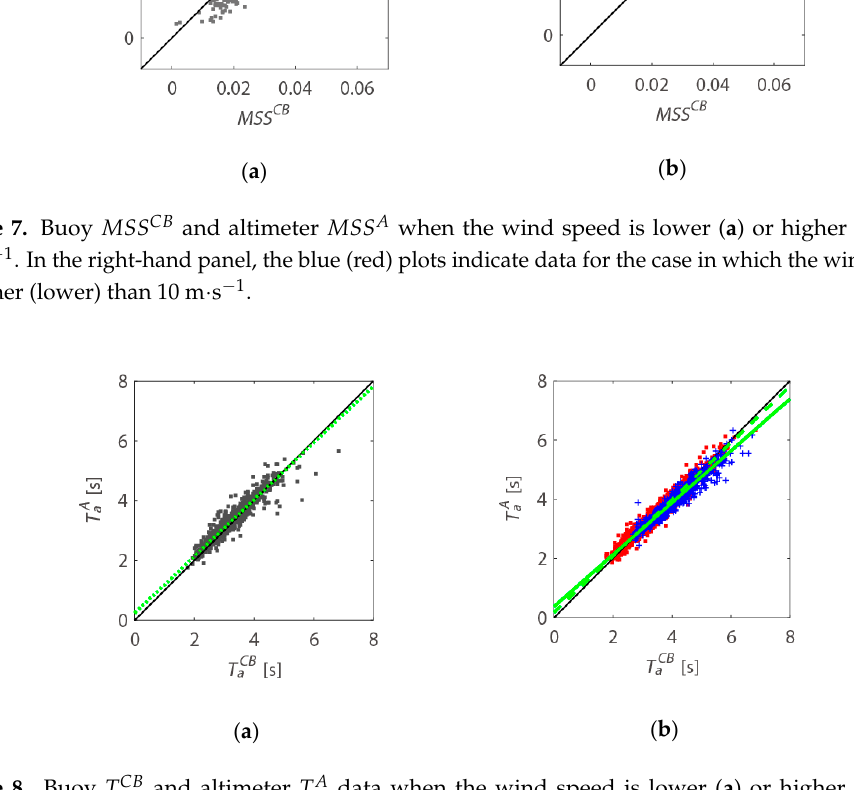
Table 2. Correlation coefficient (CC), bias, slope of the regression line, and root mean square difference (RMSD) around the regression line for T A a and T CB a for various ranges of wind speed. All CC are significant at the 99.9% confidence